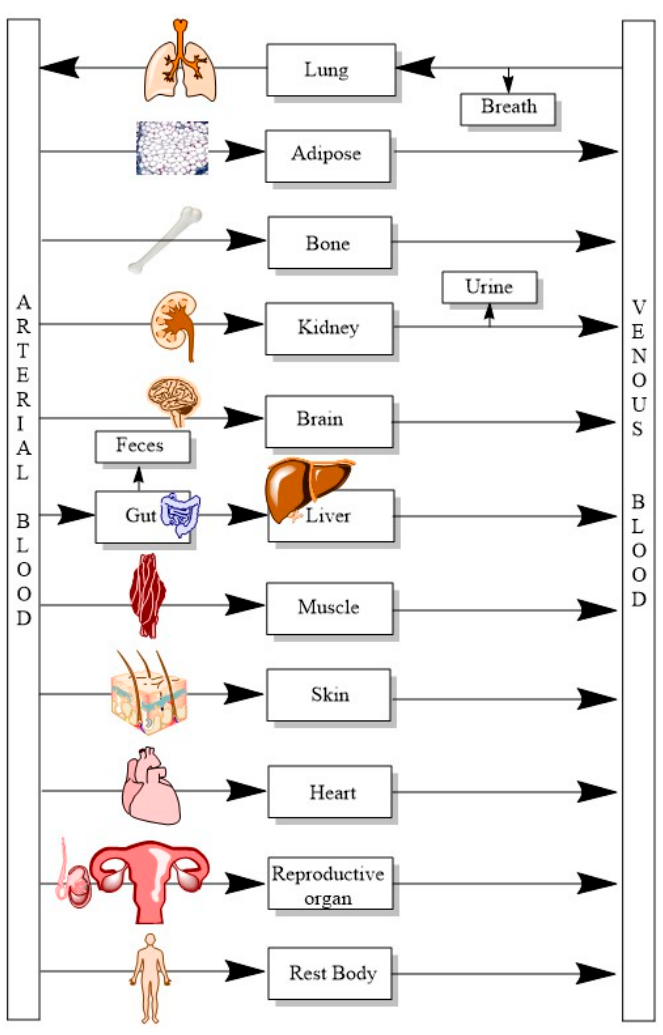
Figure 3. Multi-compartment PBPK model with 12 compartments. Excretion of the compound is from feces via gut, urine via kidney and breath via lung,